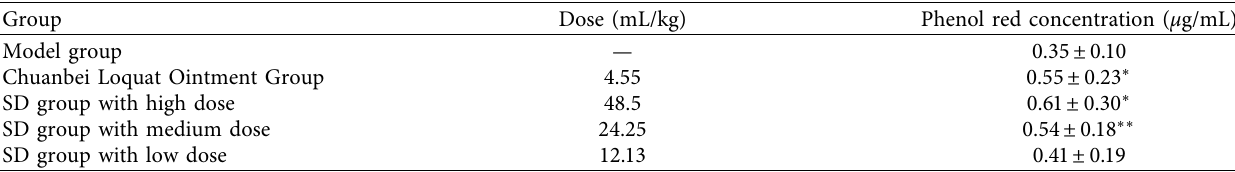
Table 10: Effect of SD on phenol red excretion in the trachea of mice ( x ± s , n �